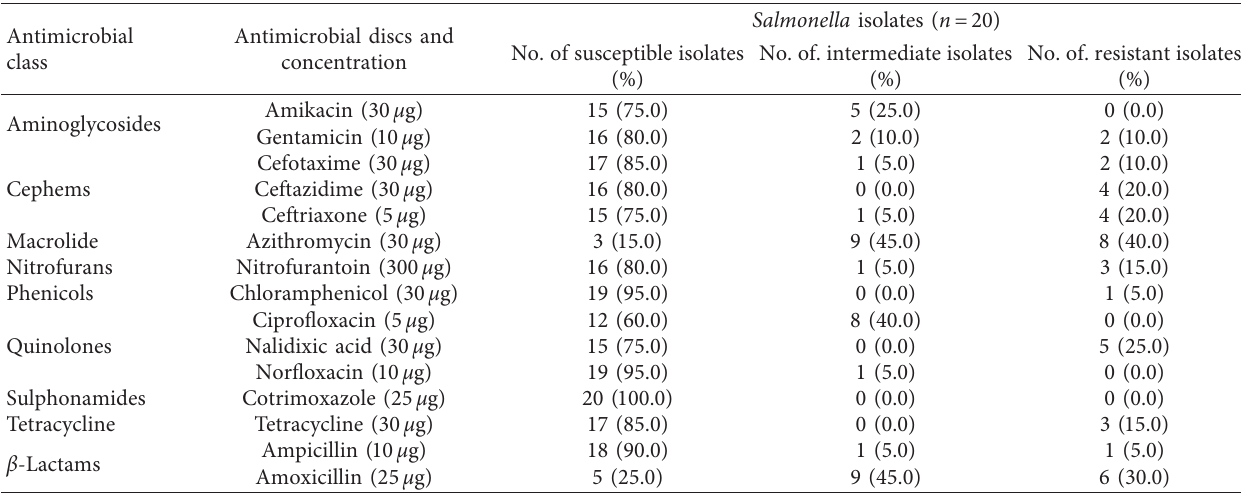
Table 3: Antimicrobial susceptibility test of Salmonella isolates from meat samples of Ambo and Holeta towns, central Ethiopia. Antimicrobial